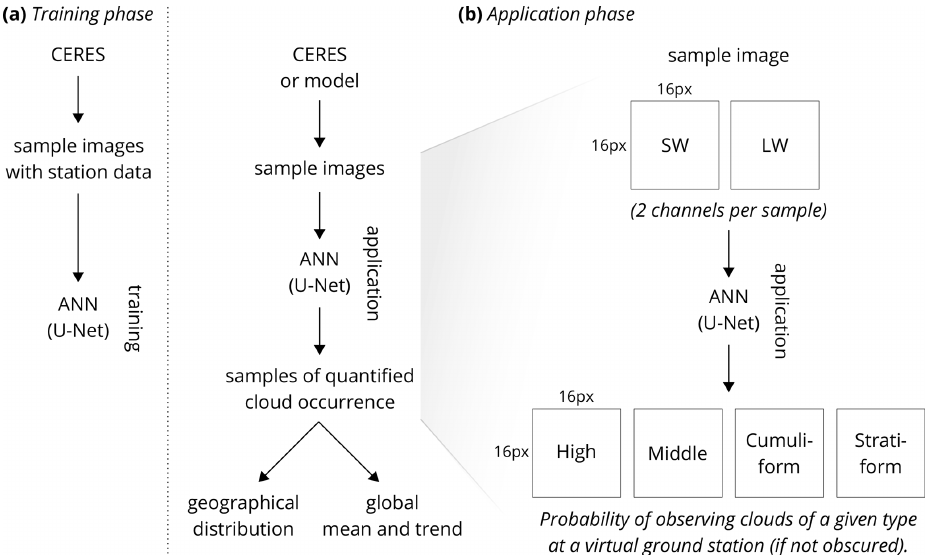
Figure 2. Schematic showing the principle of training and applying the ANN. (a) Sample images from CERES with reference ground station data (WMO cloud genera) are used in the training phase. (b) In the application (“prediction”) phase, the ANN quantifies cloud type occurrence in sample images from CERES or a model. The ANN takes a sample image consisting of SW and LW channels and produces per-pixel quantification of the probability of observing a given cloud type at a virtual ground station located in the pixel. The samples are 16 × 16 pixels in size and 4000 × 4000km